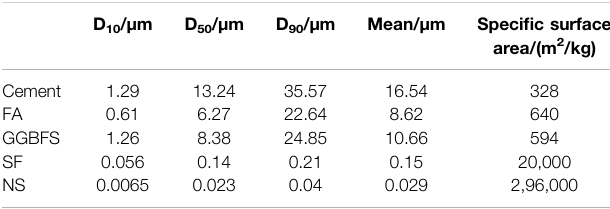
TABLE 2 | Characteristic particle size and speci fi c surface area of cement, SCMs, and NS.